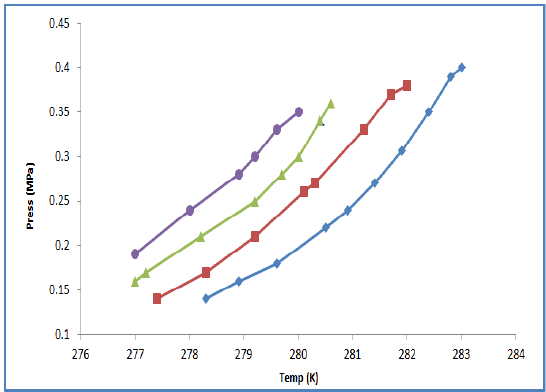
Fig. 8. R134a hydrate dissociation data for the R134a - water - NaCl system this work: ■ without salt, ■ 0.09 mol/kg, ▲ 0.17 mol ̸ kg ● 0.26